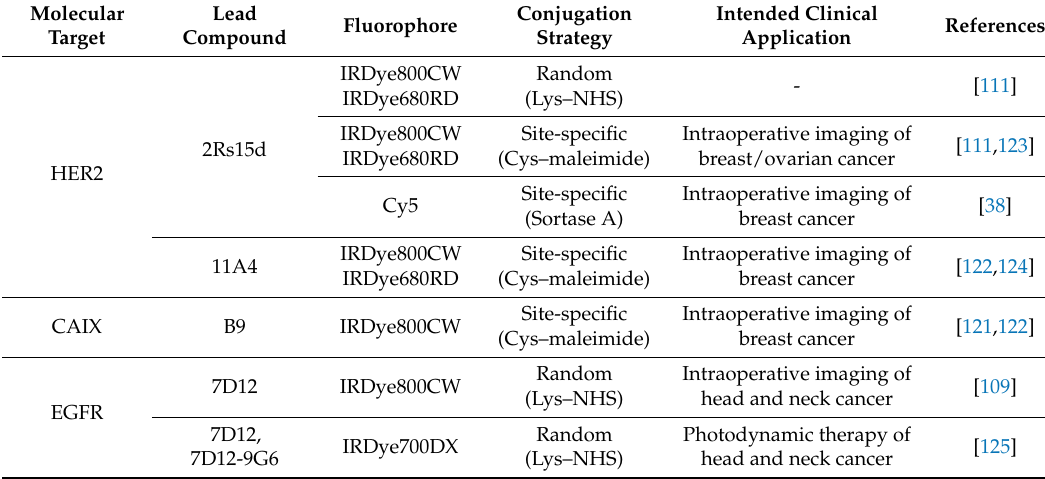
Table 2. Overview of in vivo preclinically evaluated fluorescent nanobodies with potential for clinical interventional molecular imaging and photodynamic therapy.